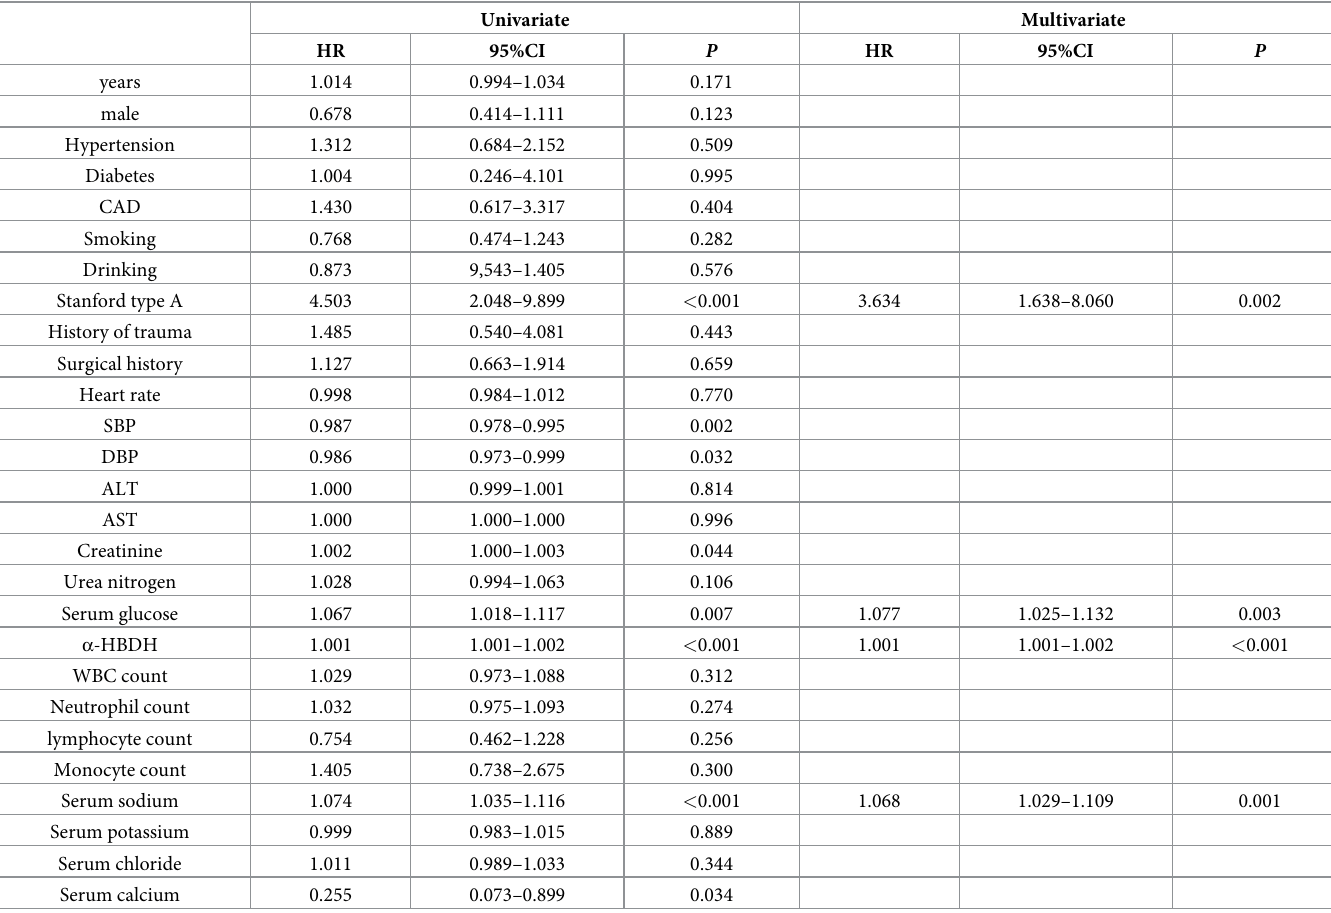
Table 4. Univariate and multiple Cox analysis for in-hospital mortality of serum sodium quartiles groups.